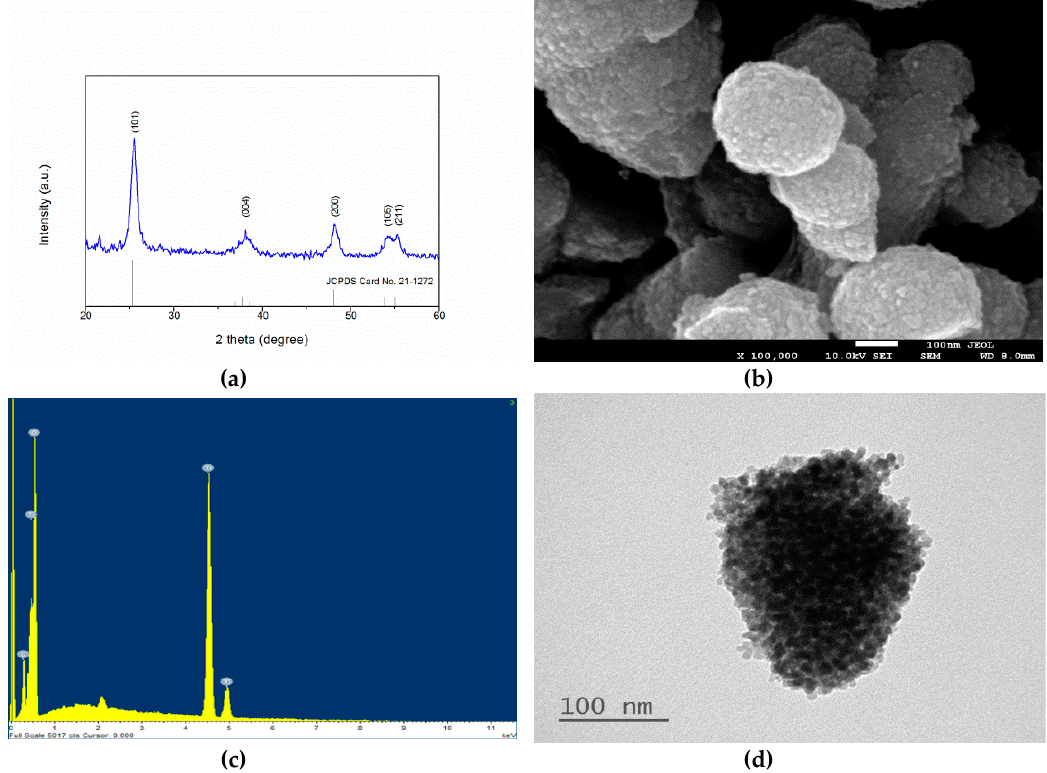
Figure 1. Characterization of the synthesized TiO 2 :C nanoparticles. ( a ) XRD pattern compared with the underlined reference of Joint Committee on Powder Diffraction Standards (JCPDS) card no. 21–1272 for anatase; ( b ) SEM image; ( c ) energy-dispersive X-ray spectroscopy (EDX) spectrum; and ( d ) TEM image.